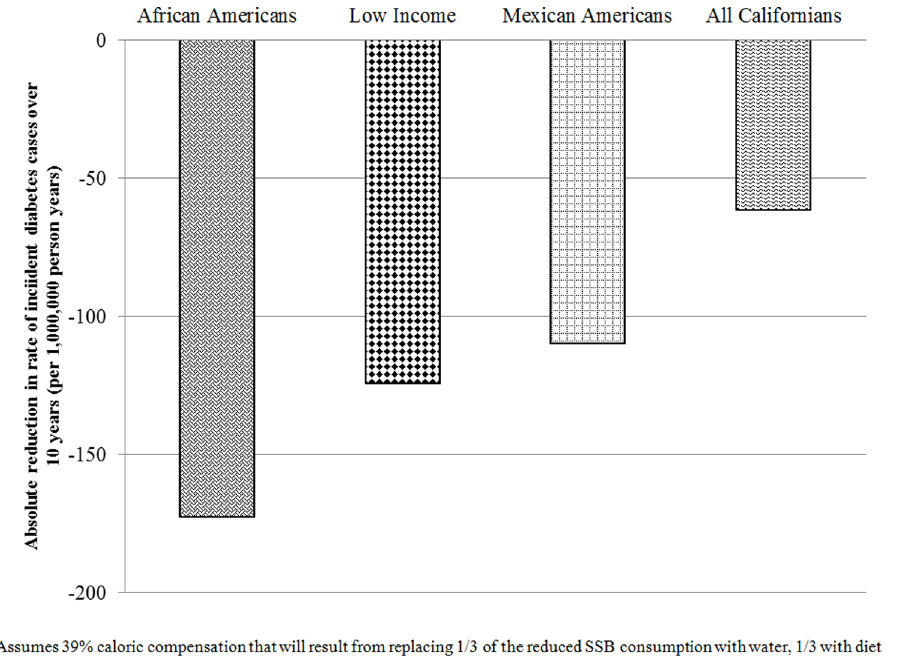
Figure 3. Projected decrease in annual incident diabetes at 10% SSB consumption reduction in subgroups of California. doi:10.1371/journal.pone.0081723.g003 PLOS ONE |